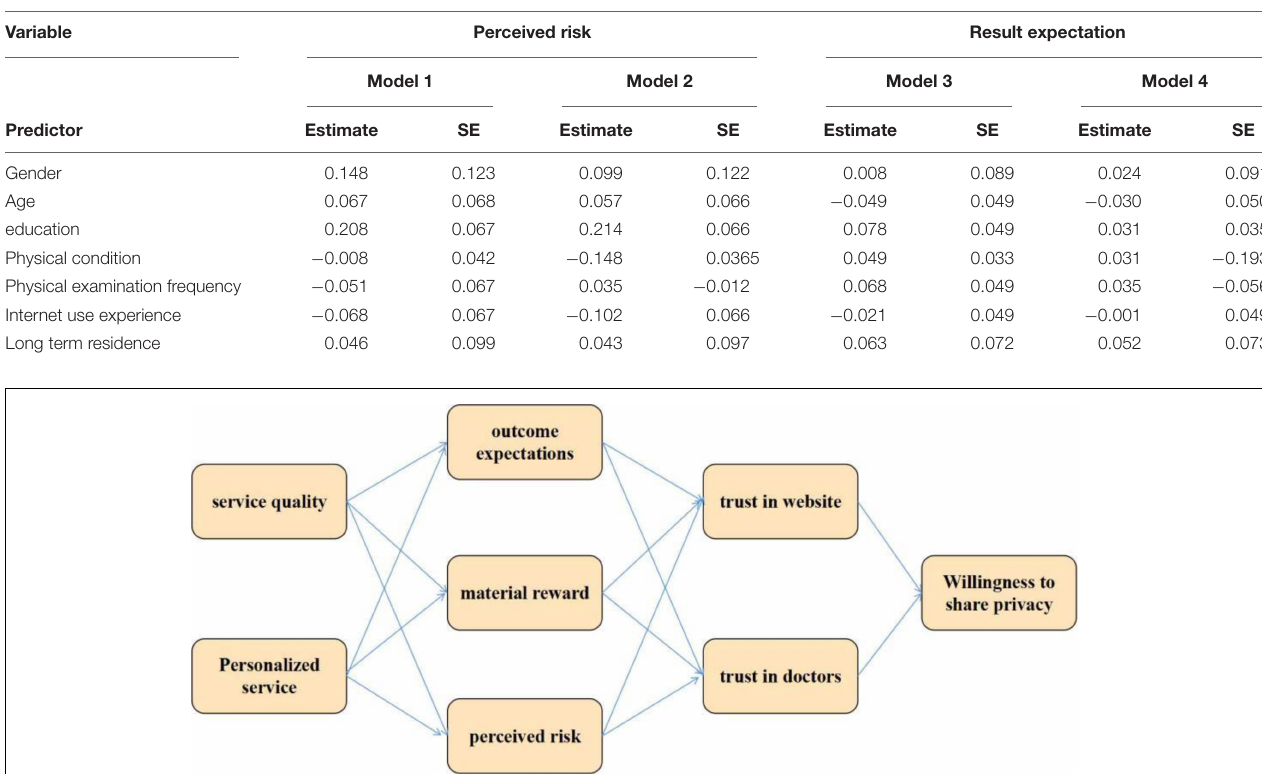
TABLE 2 | Non standardized coefficient of adjustment effect test.